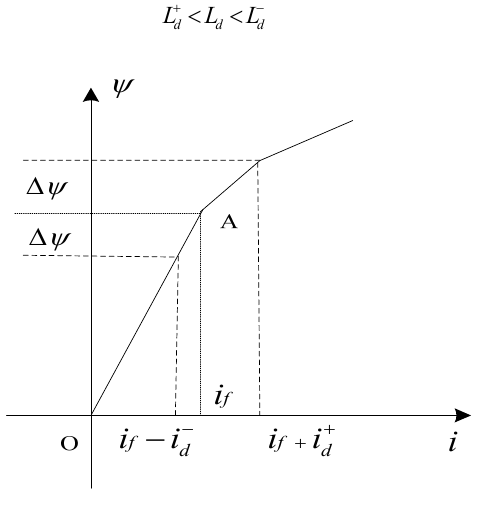
Figure 2. Characteristic curve of d-axis magnetic